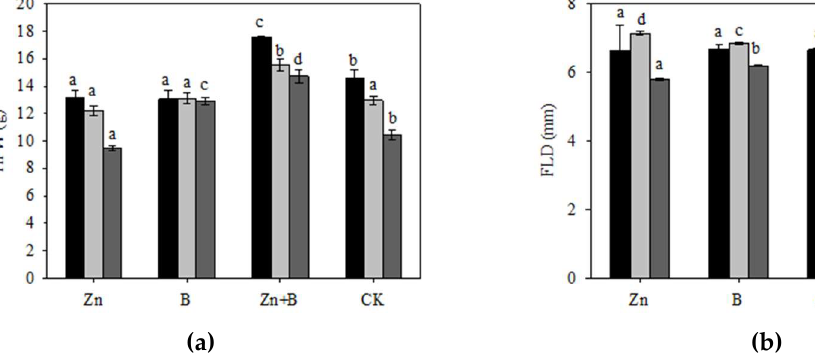
Figure 1. Effects of the foliar applications of the micronutrient solutions on the yield in L. cubeba (Lour.) Persoon. The different lowercase letters indicate significant differences ( p < 0.05) from the different foliar applications of the nutrient solutions. Identical letters indicate the absence of significant differences. The abbreviations of “Zn”, “B”, “Zn + B”, and “CK” represent ZnSO 4 , H 3 BO 4 , and ZnSO 4 + H 3 BO 4 , and the control. Error bars are standard errors. The same is as below. Table 3. Analysis of variance of yield, yield components, fruit oil content, and citral contents.